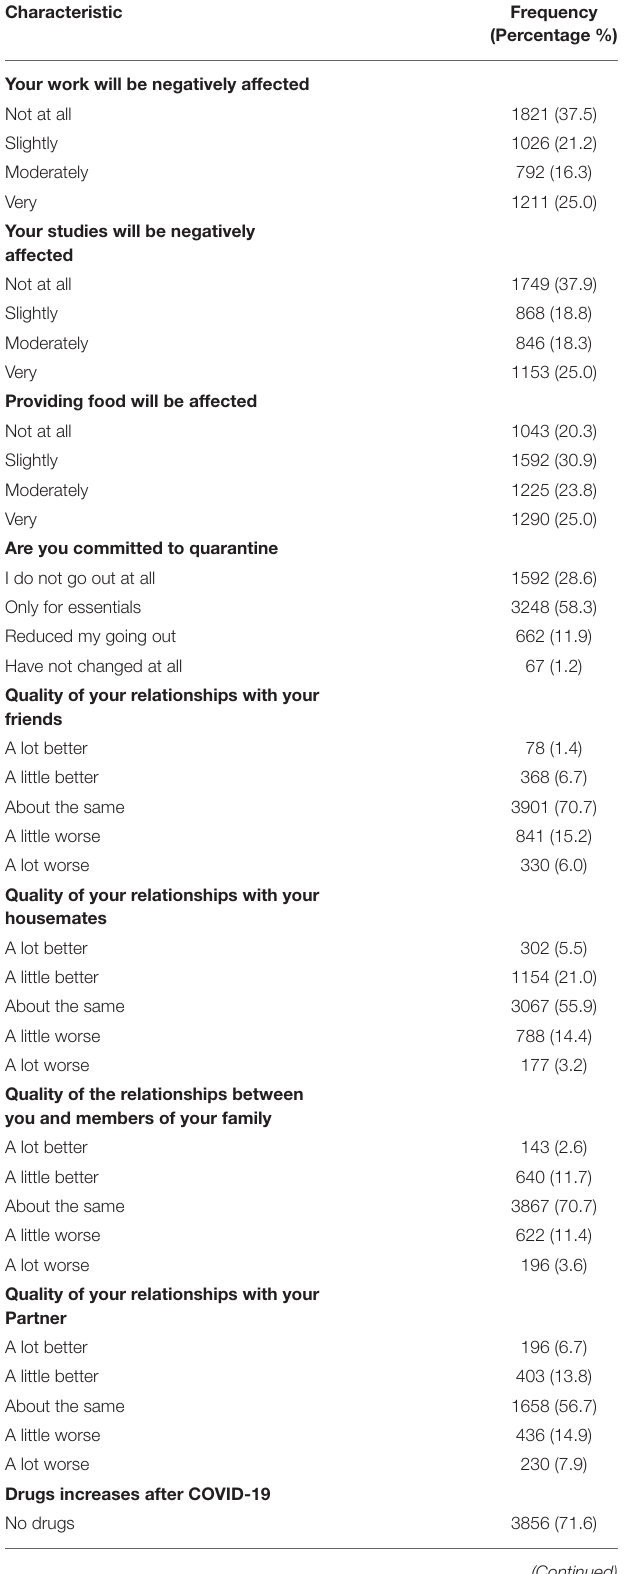
Figure 1 . All PTSD items did not correlate with